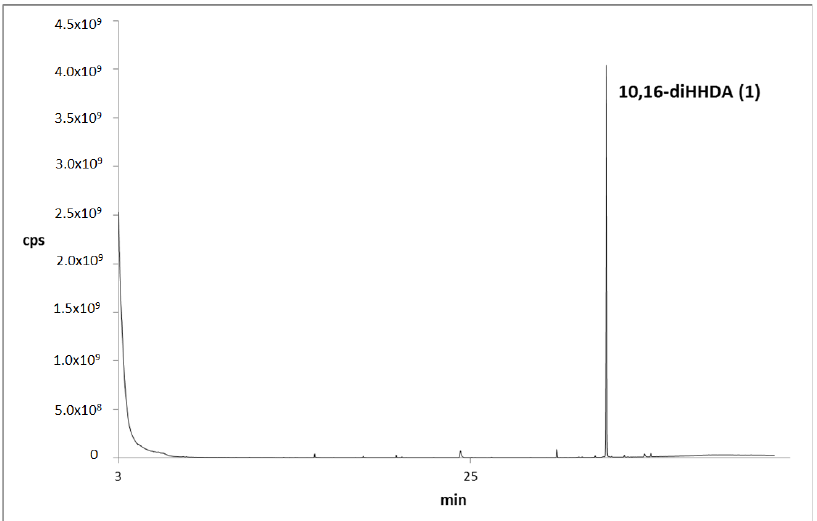
Figure A1. Chromatographic profile obtained by performing a gas chromatographic-mass spectroscopy (GC-MS) analysis of cutin monomer 1 after the depolymerization reaction. Regarding the DSC curves obtained when analyzing the mixtures PLA − X − Y reported in Table 3, the regions relative to the melting point peaks during the first heating step are reported in Figure A2.